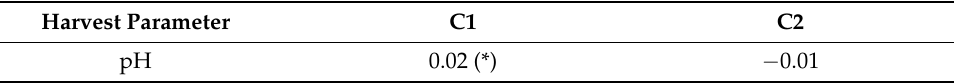
Table 6. Mean differences in planned contrasts (C1 and C2) on harvest parameter real acidity (pH). The results were significant at * p < 0.05.